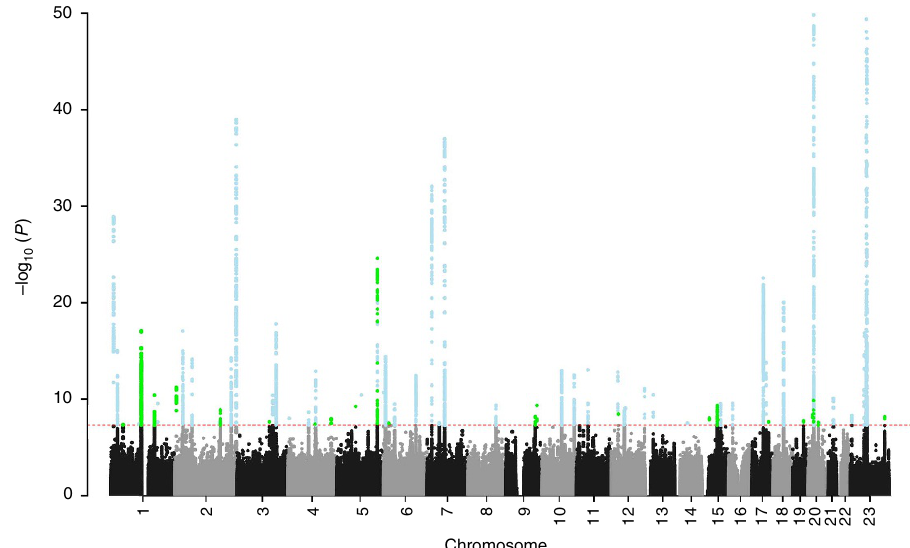
Figure 1 | Manhattan plot of association results from the genome-wide meta-analysis. Manhattan plot showing the results of the genome-wide association meta-analysis in 10,846 early-onset MPB cases and 11,672 controls. The x axis shows the chromosomal position, and the y axis shows the (cid:3) log 10 ( P -value) (METAL) of the association analysis. Previously reported genome-wide significant loci are depicted in blue; novel MPB-risk loci are depicted in green. Data points with P o 1 (cid:2) 10 (cid:3) 50 (METAL) were truncated. The lowest P -value was 1 (cid:2) 10 (cid:3) 320 (METAL) at the AR / EDA2R -locus.